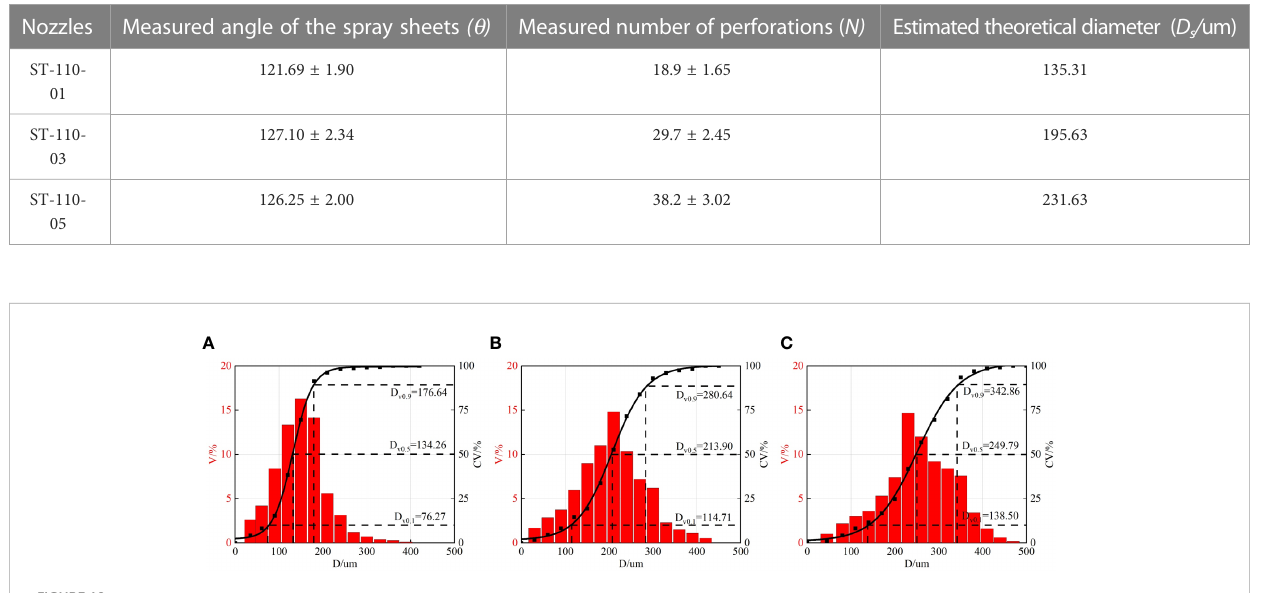
FIGURE 10 Droplet distributions for different nozzles. V% denotes percentage of volume of droplets of different sizes. CV% denotes cumulative volume of droplets. (A) ST-110-01 (B) ST-110-03 (C)